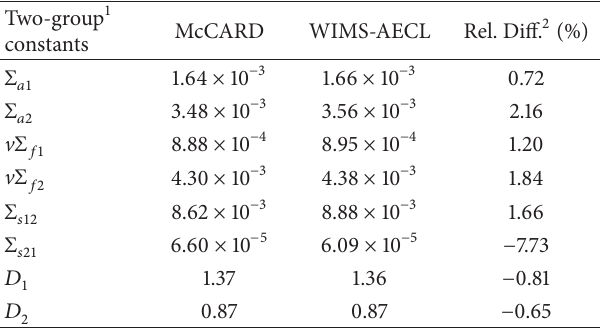
Rel. Diff: relative difference between McCARD and WIMS-AECL.